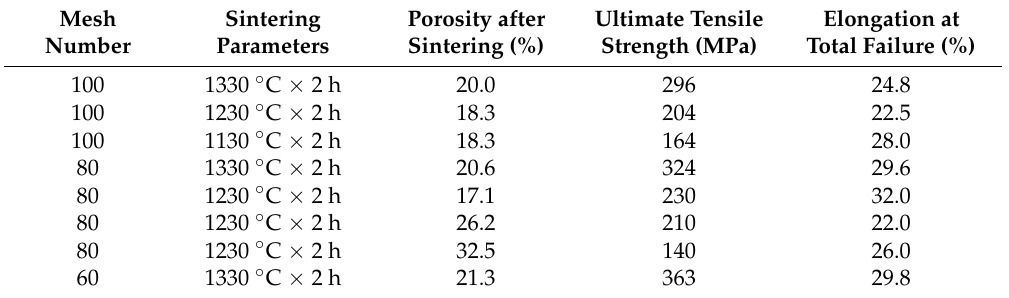
Table 2. Summary of the uniaxial tensile properties for the sintered wire mesh porous plates.